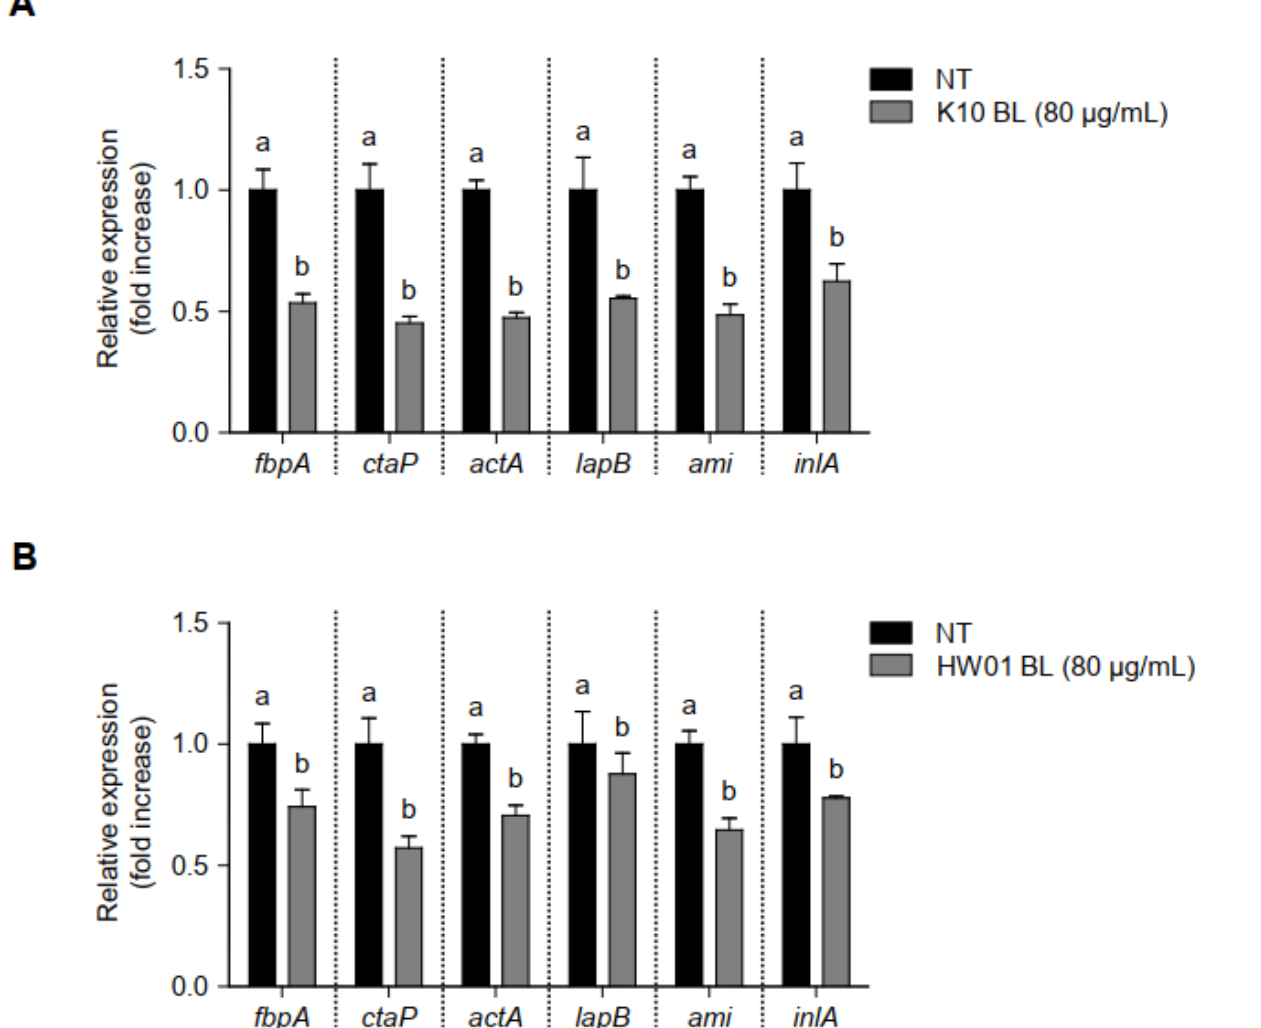
Figure 6. Regulation of gene transcription associated with L. monocytogenes adhesion and invasion in the presence or absence of P. acidilactici BLs. K10 BL ( A ) or HW01 BL ( B ) (80 μ g/mL) was preincubated for 3 h in a culture plate, after which L. monocytogenes was added and cultured at 37 °C for an additional 24 h. The expression levels of fbpA , ctaP , actA , lapB , ami , and inlA were measured using qRT-PCR. The results are represented as the means ± standard deviations from three independent experiments ( p < 0.05). Significant differences between treatment with K10 BL or HW01 BL are expressed with different letters (a and b).